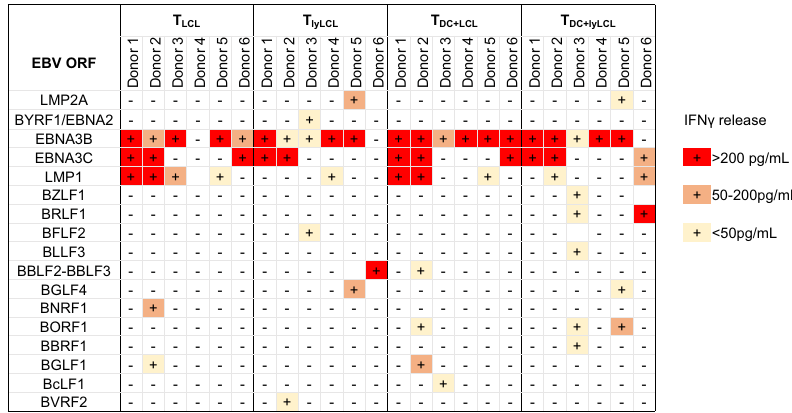
Fig. 4 Summary of HLA-B*57:01 restricted responses. Positive ORF targets are arranged vertically in the order of their temporal phase. Individual CD8 + T cell responses to targets expanded from four stimulation assays are marked by shaded squares, with red squares identifying prevalent responses (IFN γ > 200 pg/mL), orange squares identifying moderate responses (IFN γ 50 – 200 pg/mL) and light shade squares identifying weak responses (IFN γ < 50 Having de fi ned the TCRs to recognize EBV epitopes, the Likewise, there was no response of VSF speci fi c T cell clones hypothesis that EBV-speci fi c TCRs could cross-recognize abaca- vir modi fi ed self-peptide was tested. Jurkat cells transfected with QSR-TCR were co-cultured with abacavir (10 µg/mL) pulsed Data 1). Furthermore, screening the effects of abacavir on T cell K562-HLA-B * 57:01, C1R-HLA-B * 57:01 cells or autologous recognition using a polyclonal mix of EBV-speci fi c T cells also LCLs. The addition of abacavir alone did not activate QSR-TCR demonstrated no cross-reactivity to trimolecular complex of transfected Jurkat cells (Fig. 9c, e; Supplementary Data 1). HLA-B * 57:01, self-peptide and abacavir (Supplementary Fig. 4a,